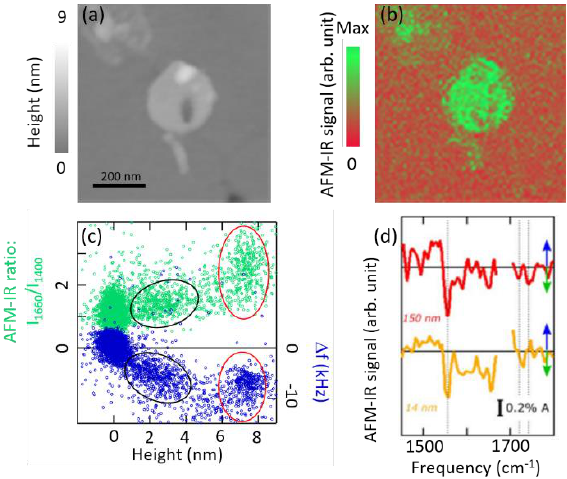
Fig. 2. (a) AFM topography of a single ChR2 membrane patch. (b) AFM-IR map acquired at 1660 cm -1 normalized by the map acquired at 1400 cm -1 . (c) Scatter plot of the ratio I 1660 /I 1400 (green dots) and of the variation of the resonance frequency  f=f-f Au of the tip (blue dots) as a function of topographic height. (d) AFM-IR difference-absorbance spectra obtained on 150 nm-thick (red curve) and 14 nm-thick (yellow curve) areas of the ChR2